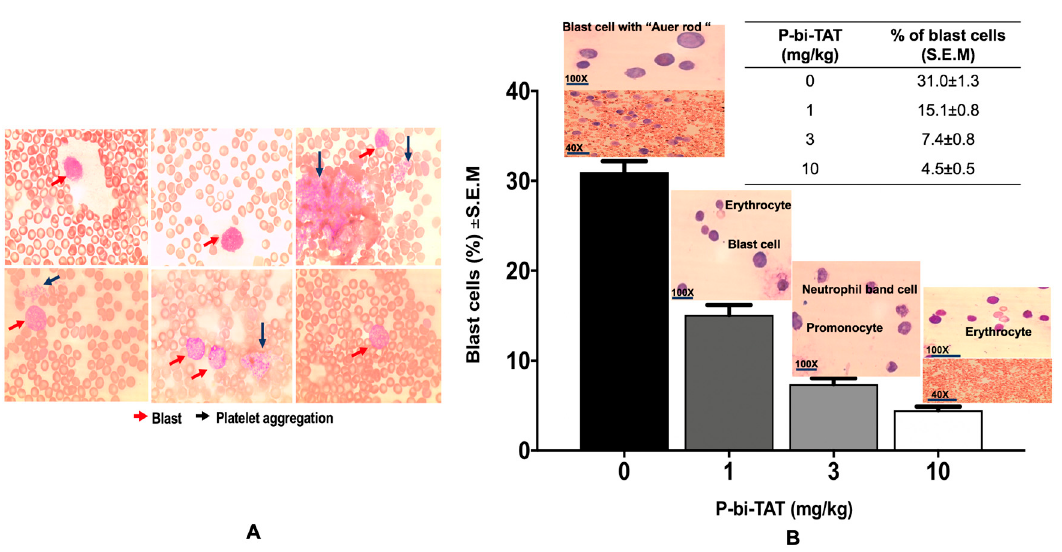
Figure 2. Evaluation of blast cells in peripheral blood smear. ( A ) Blast cells in the blood smears of NOD/SCID mice injected with THP1-lucia after 16 days. Red arrow, blast cells; Black arrow, platelets aggregation. ( B ) Blood smear with Lishman stain represent AML control blood smears vs. P-bi-TAT-treated animal cells. Control group shows many blast cells in the peripheral blood, and P-bi-TAT (3 mg/kg) treated animal shows no blast cells. Results are expressed as mean ± S.D., n = 4–5 mice/group.